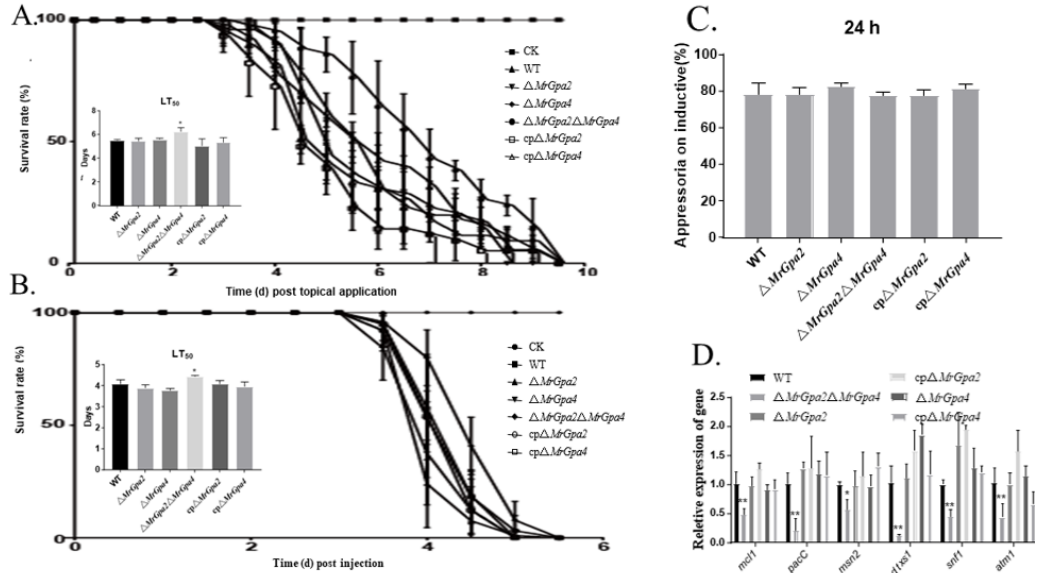
Figure 7. MrGpa2 and MrGpa4 impact fungal virulence. ( A ) Survival rate and LT 50 (days) of G.mellonella after topical application of conidial suspensions in six fungal strains. The control insects were treated with sterile water. ( B ) Survival rate and LT 50 (days) of G.mellonella after injection with conidial suspensions in six fungal strains. The control insects were treated with sterile water. ( C ) The appressorium formation rates of six fungal strains. ( D ) Expression levels of virulence-associated genes. * p < 0.05, ** p < 0.01.